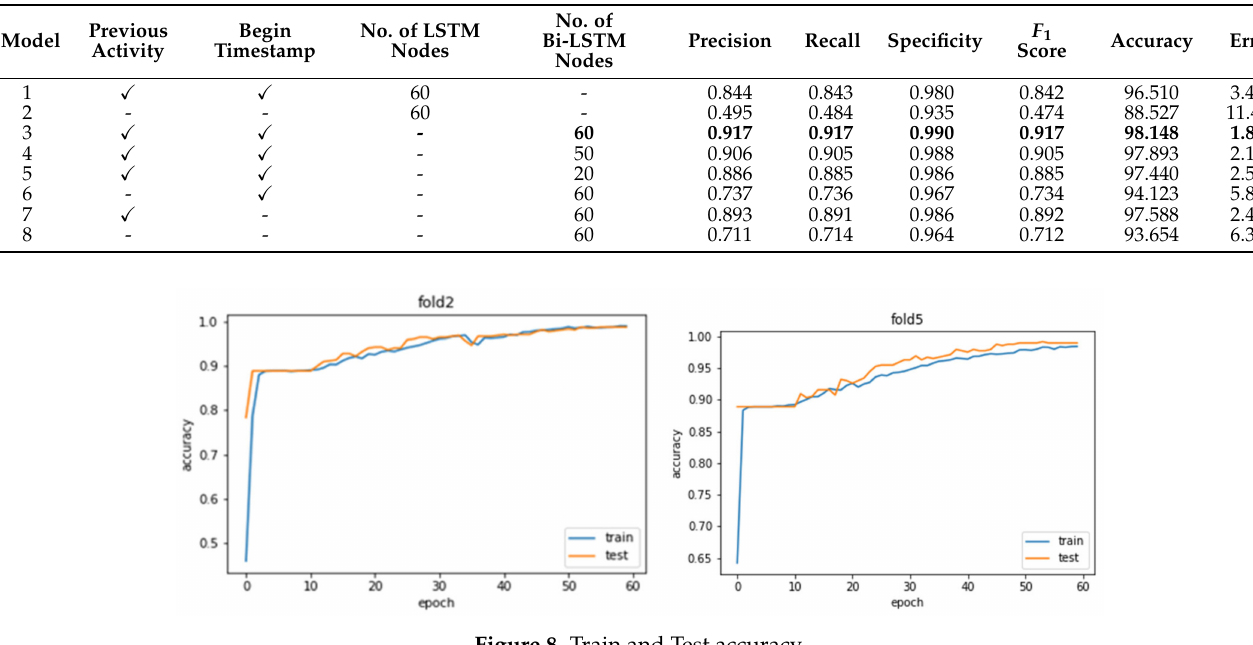
Figure 8. Train and Test